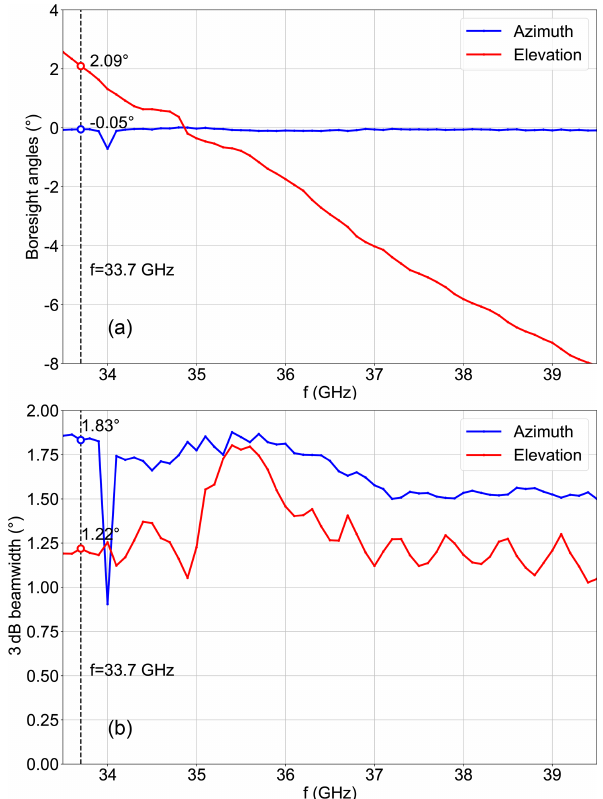
Figure C2. Frequency dependence of the KaRADOC main lobe azimuth and elevation boresight angles (a) as well as half-power beamwidths (b)